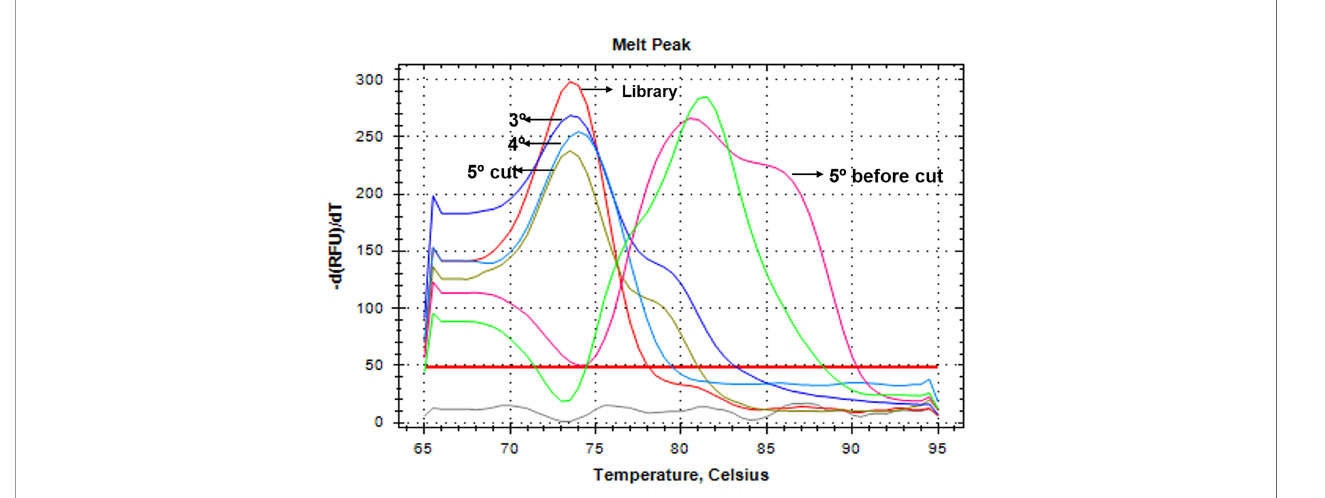
FIGURE 2 | Melting curve of the Real time PCR performed after SELEX rounds. The positive control (library) is shown in red, and the SELEX round is shown with a black arrow. In pink, the 5 th round before the gel and in brown the same 5 th round but after cutting the band form the agarose gel, restoring the right peak.